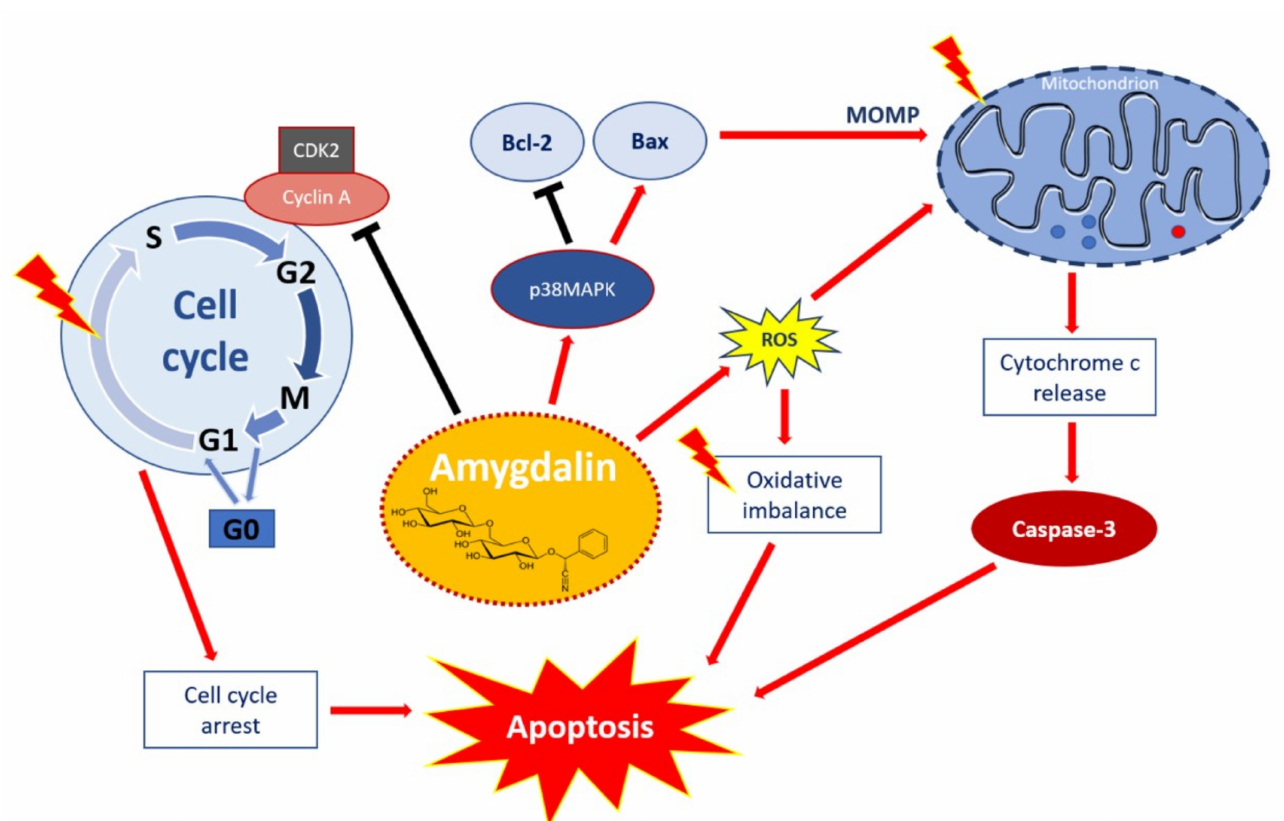
Figure 2. Apoptotic effect of amygdalin via multiple cellular signaling pathways. Amygdalin activates p38MAPK, which affects death stimuli: activates Bax apoptotic proteins, and inhibits Bcl-2 anti-apoptotic proteins. Apoptosis- related proteins induce mitochondrial outer membrane permeabilization (MOMP), a decisive event in the process of cytochrome c release. Activation of the release of cytochrome c as a mitochondrial response to proapoptotic stimuli via the mitochondrial or intrinsic apoptotic pathway ultimately leads to activation of caspases including caspase-3, which induces apoptosis. Amygdalin induces ROS overproduction, which compromises oxidative balance and eventually leads to apoptosis. Amygdalin down-regulates cyclin-dependent kinase 2 (CDK2) and cyclin A, which induces cell cycle arrest in G0/G1 phase. Amygdalin also inhibits cell transfer from G1 to S phase resulting in the inhibition of cell proliferation and growth. ‘Activation’ shown by red arrows and ‘inhibition’ showed by black